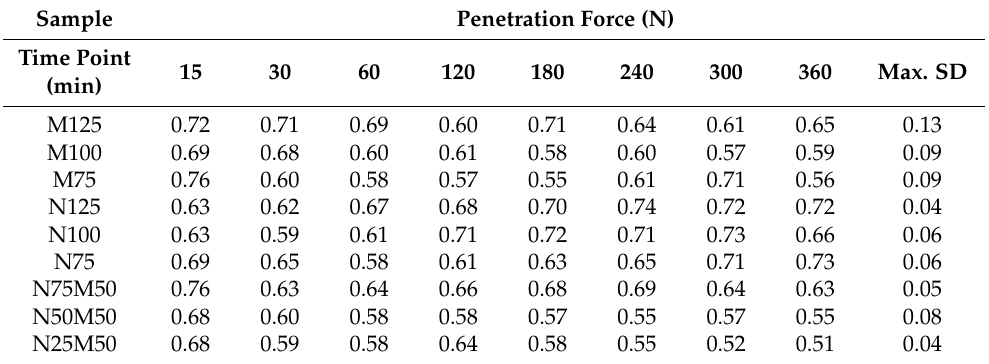
Table 5. Penetration force of gel layer of swollen matrices measured by texture analyser for 6 h.